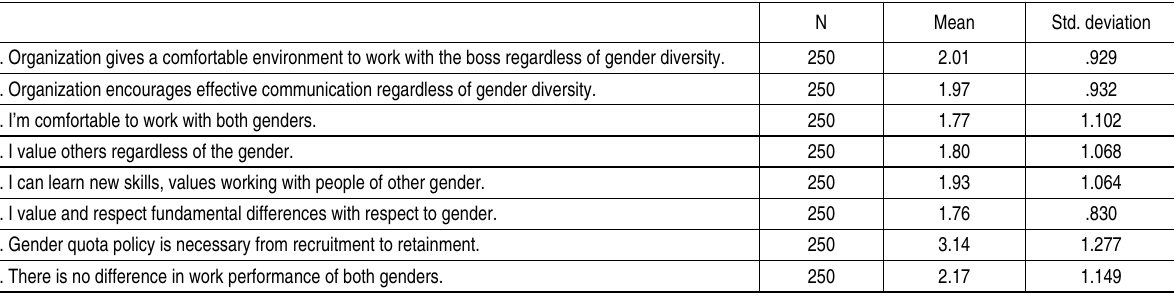
Table 7. Acceptance of gender